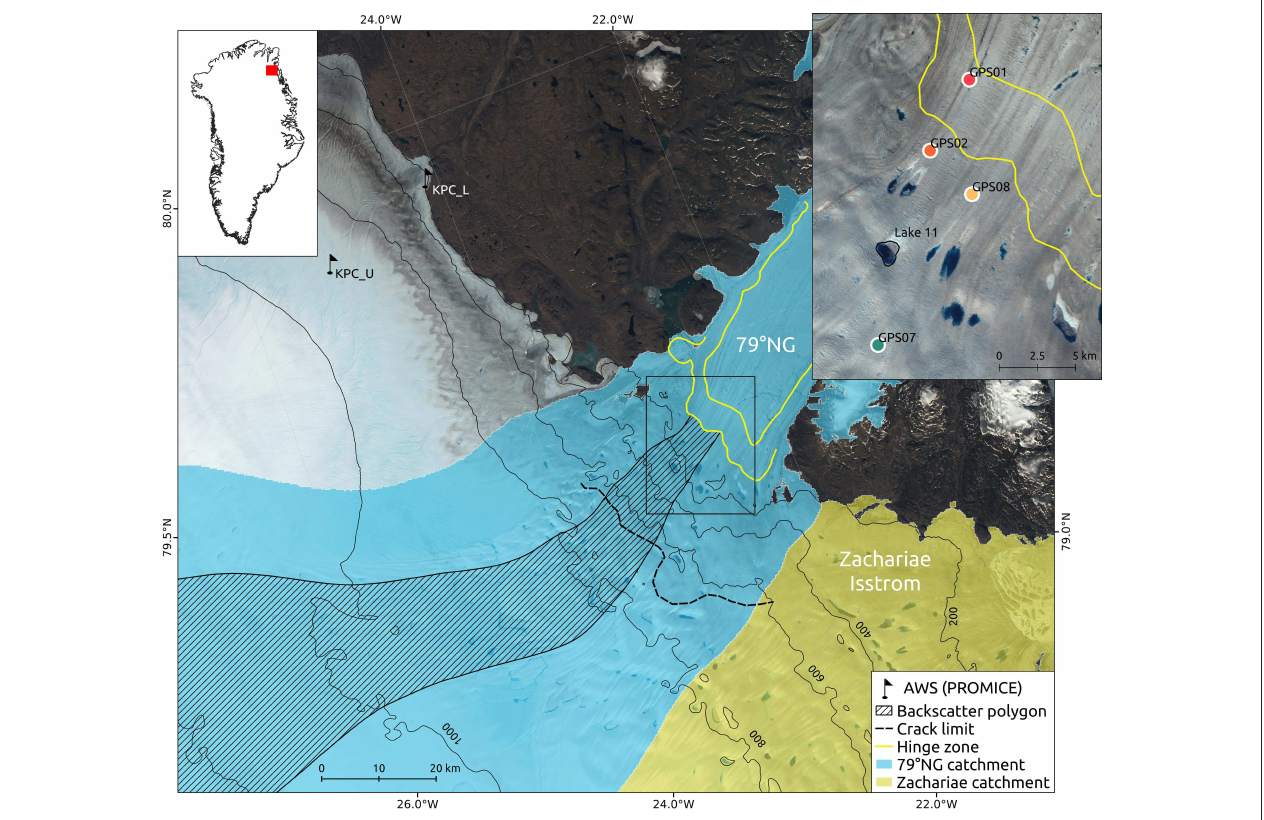
FIGURE 1 | Overview of the study area. Hatched polygon marks the area used for the backscatter analysis shown in Figure 2b . Catchment areas are from Krieger et al. (2020) . Inlet shows the locations of GPS receivers shown in Figure 3 and Figure S2 . KPC_U and KPC_L are the closest Automatic Weather Stations (AWS) from the PROMICE project (Fausto and van As, 2019). In the background is a Sentinel-2 acquisition from 28 July 2017. Hinge zone is determined from ERS-II SAR interferometry, data were acquired in April/May 2011. Upper limit of major crevasses is shown as dashed black